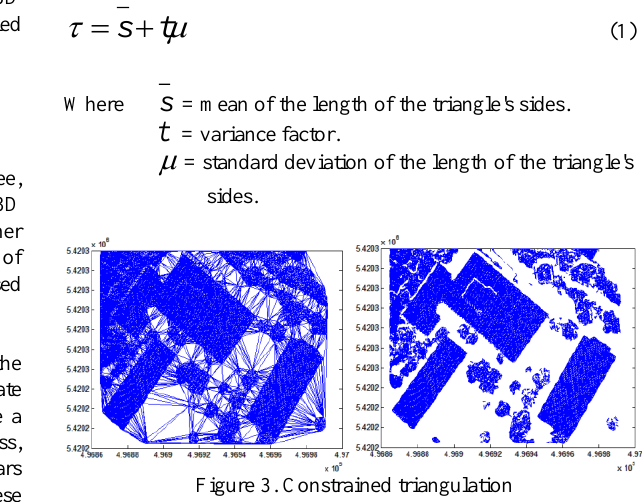
Figure 3. Constrained triangulation The objectives of segmentation are detection of remained non- building points more especially vegetation points, labelling points belonging to the same plane and extraction of building planes points. Triangles which belong to the same plane will have same normal vector direction. This property has been used to segment all the points. Unit normal vector of each triangle is calculated by external multiplication of two vectors and 2 v 1